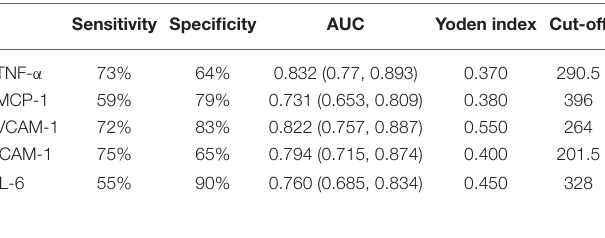
TABLE 10 | Comparison of the sensitivities and specificities of TNF- α , MCP-1, VCAM-1, ICAM-1, and IL-6.